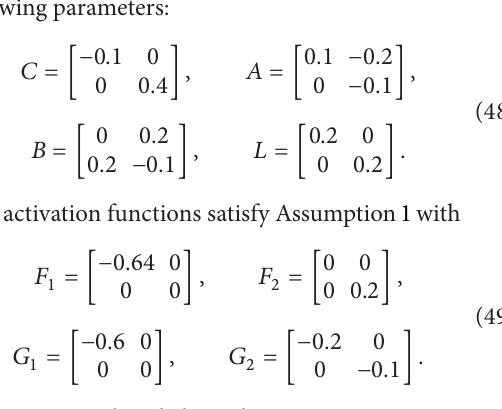
represent the trajectories of 𝑥(𝑘) and the state estimator ̂𝑥(𝑘) with the initial condition 𝑥(𝑘) = [−1, 0.5] , ̂𝑥(𝑘) = [−0.5, −0.5] . And from Theorem 10, it follows that the